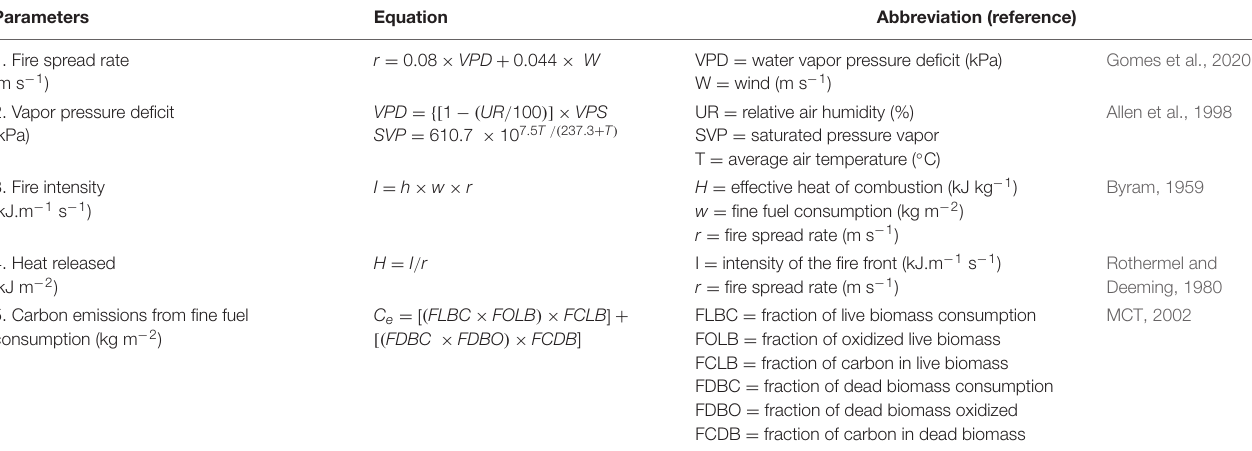
TABLE 1 | Equations used in the BEFIRE